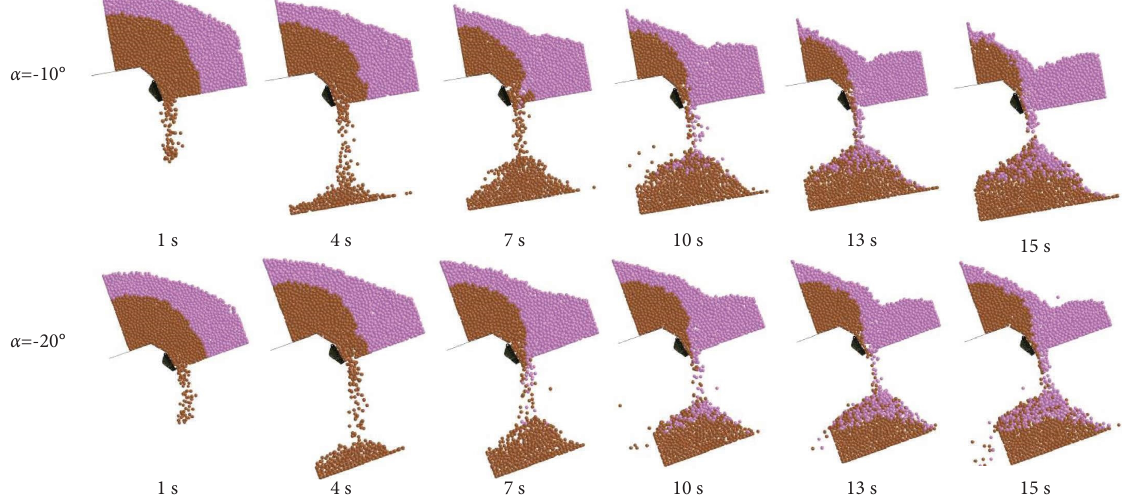
Figure 26: Te coal-caving process when the angle of depression is − 10 ° and − 20 ° .